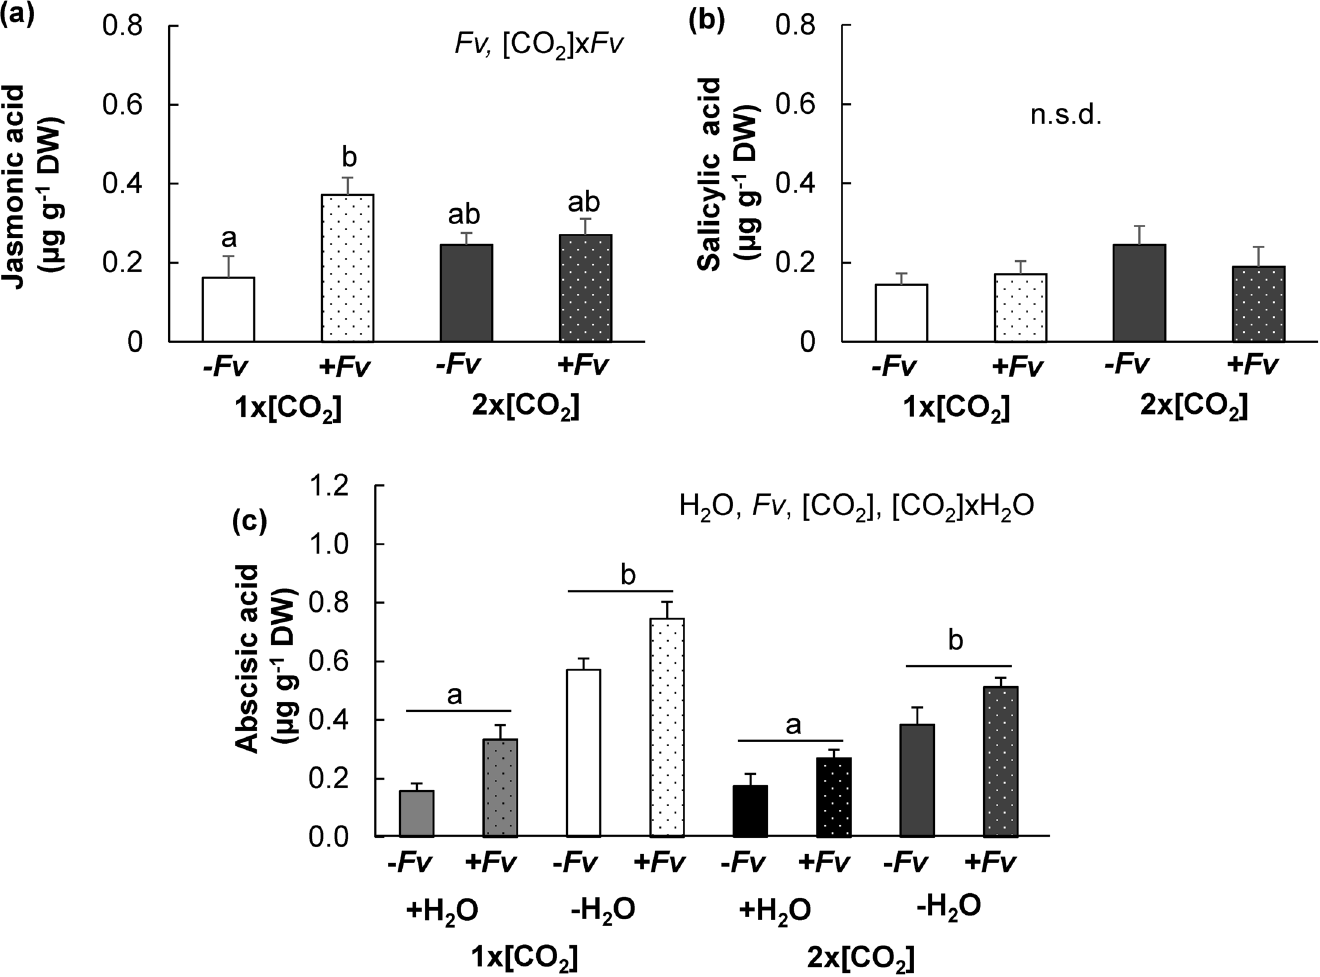
Fig 5. Effects of 2x[CO 2 ] and drought ( – H 2 O) on maize phytohormone responses to F . verticillioides ( Fv) inoculation. Mean concentration ± SEM of (a) jasmonic acid (JA), (b) salicylic acid (SA), and (c) abscisic acid in maize stem tissues grown at 1x[CO 2 ] or 2x[CO 2 ] with irrigation (+H 2 O) or without irrigation (-H 2 O) conditions two days after mock inoculation (- Fv ) or F . verticillioides inoculation (+ Fv ) were determined. Individual and interacting factors significantly contributing to differences are indicated at the top right corner of each graph (2x2x2 ([CO 2 ]xH 2 Ox Fv ) ANOVA, n = 4, P < 0.05).